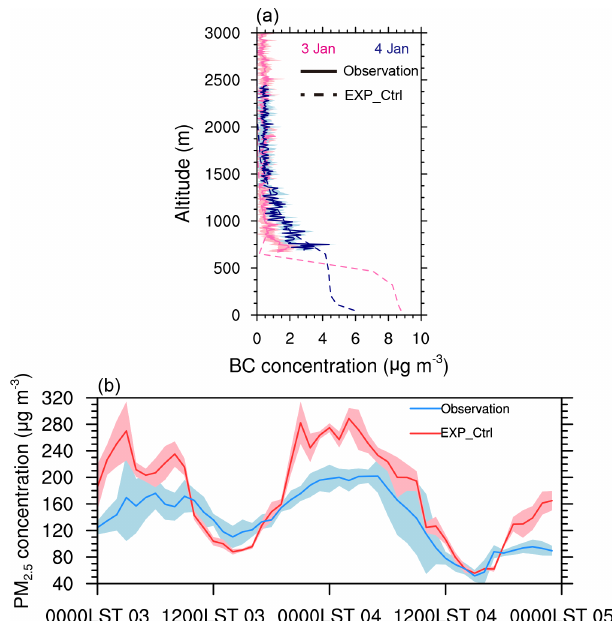
Figure 3. Validation of aerosol concentration between the modeling (EXP_Ctrl) and in situ observations. (a) Aircraft-measured BC con- centration vertical distributions. (b) Ground-based observed PM 2 . 5 concentration. The shaded areas indicate the error bars (standard deviation).